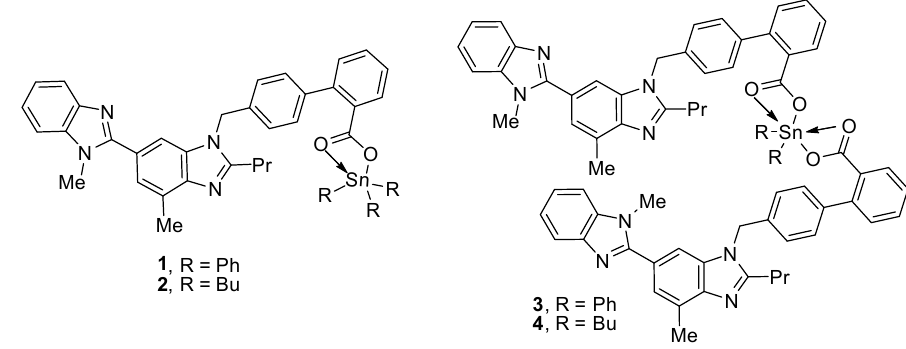
Figure 1. Organotin(IV) compounds 1 – 4 .